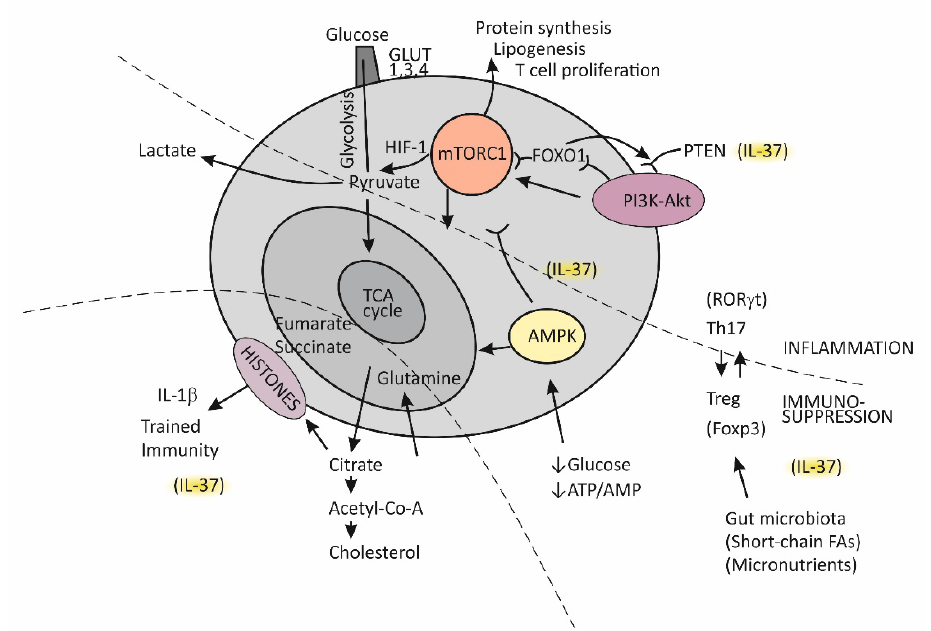
Figure 3. Metabolic reprograming in chronic inflammation and the balance between the tolerogenic and inflammatory immune axis.